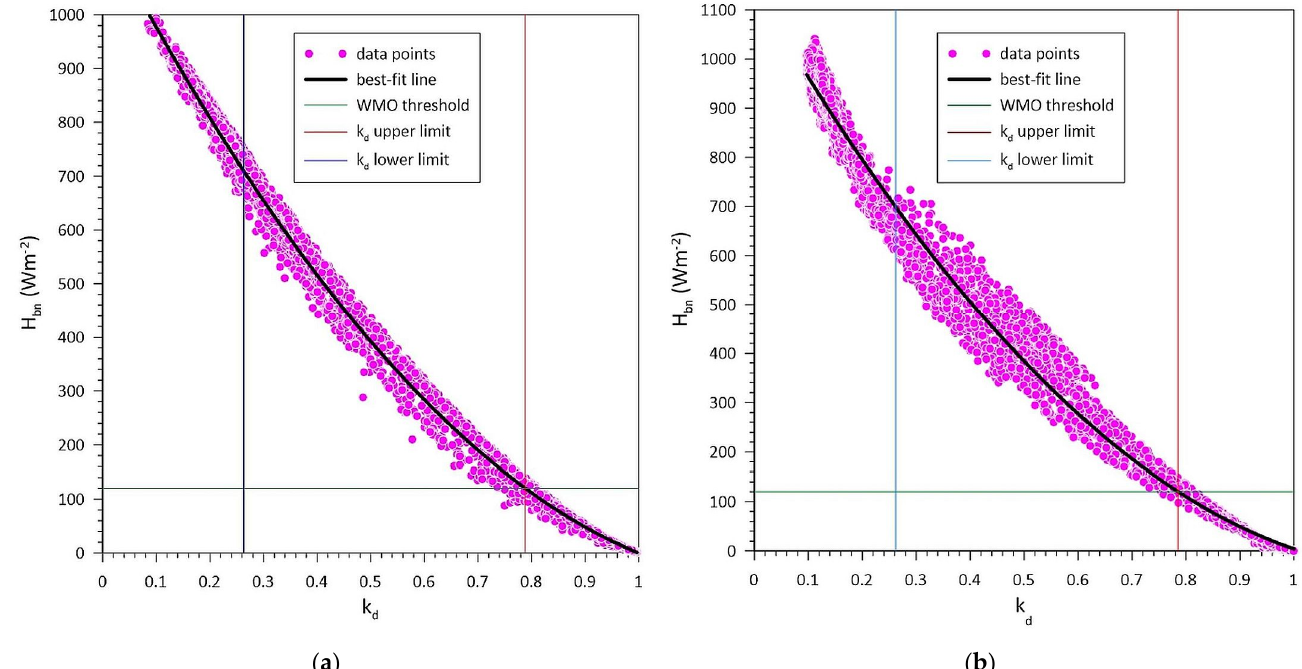
Figure 4. Determination of the k du (red line) and k dl (blue line) values for the ( a ) ATH and ( b ) BOU sites.